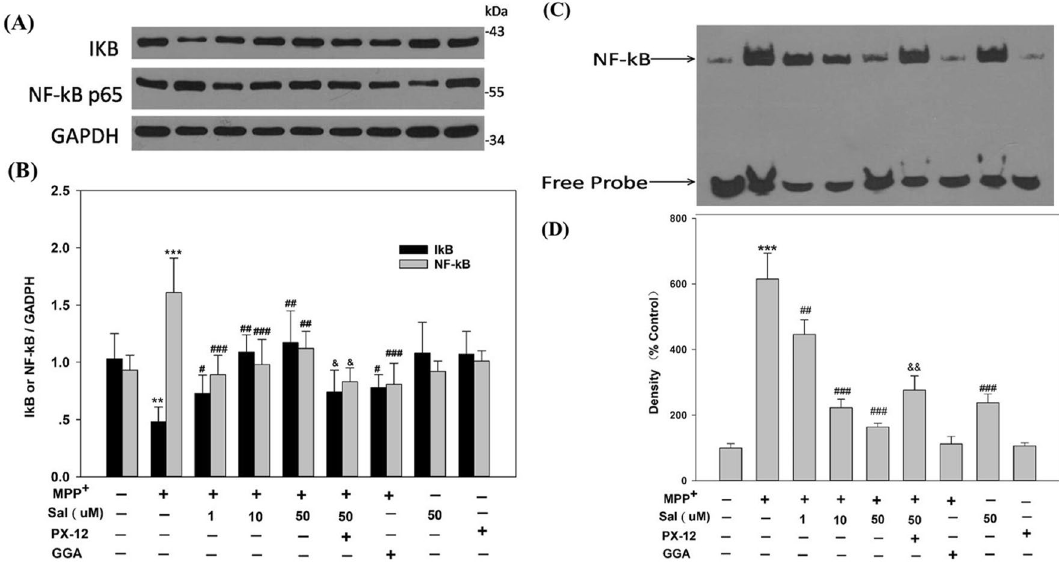
Figure 6. Schisanheno inhibits IκB degradation, NF-κB translocation and NF-κB-DNA binding activity in SH-SY5Y cells treated with MPP + via Trx1. Cells were treated with Sal (1 µM, 10 µM, and 50 µM ) for 24 h before exposed to MPP + (500 μΜ) for 48 h. The degradation of IκB and NF-κB nuclear translocation were detected by Western blot ( A and B ). Nuclear proteins were extracted, then NF-κB-DNA binding activity was determined by EMSA ( C and D ). Data were expressed as mean ± SD. ** P < 0.01, *** P < 0.001 vs corresponding Control group; # P < 0.05, ## P < 0.01, ### P < 0.001 vs corresponding MPP + group; & P < 0.05, && P < 0.01 vs corresponding Sal 50 μM + MPP + group. Similar results were obtained with six separate